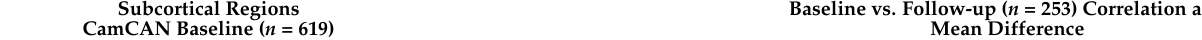
Table A2. Subcortical regional activity norms. These norms and test-retest reliability measures were obtained as described in Table A1.